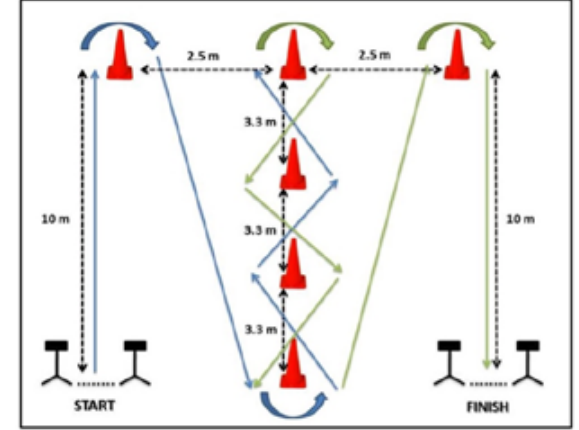
Figure 1. Illinois Agility Test